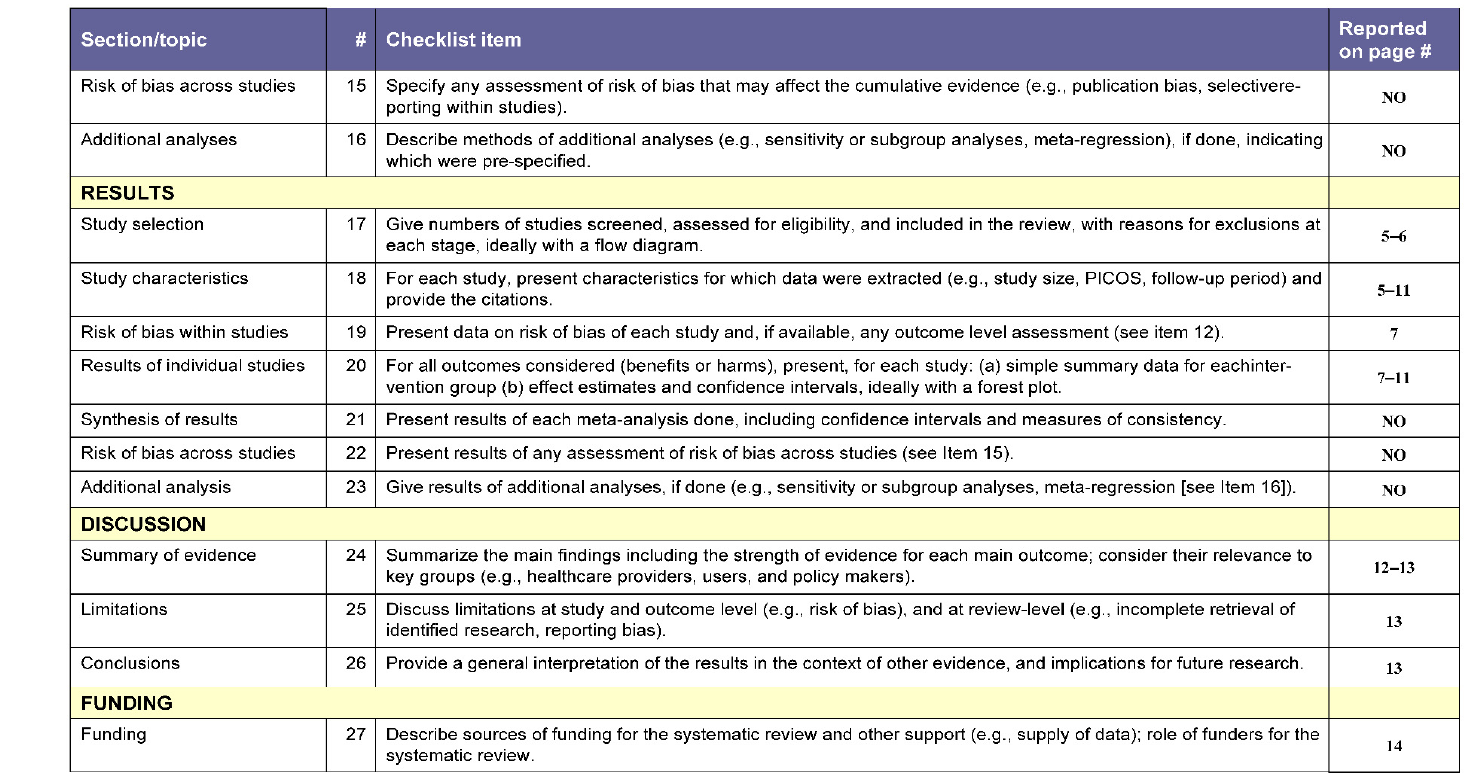
Figure A1. PRISMA